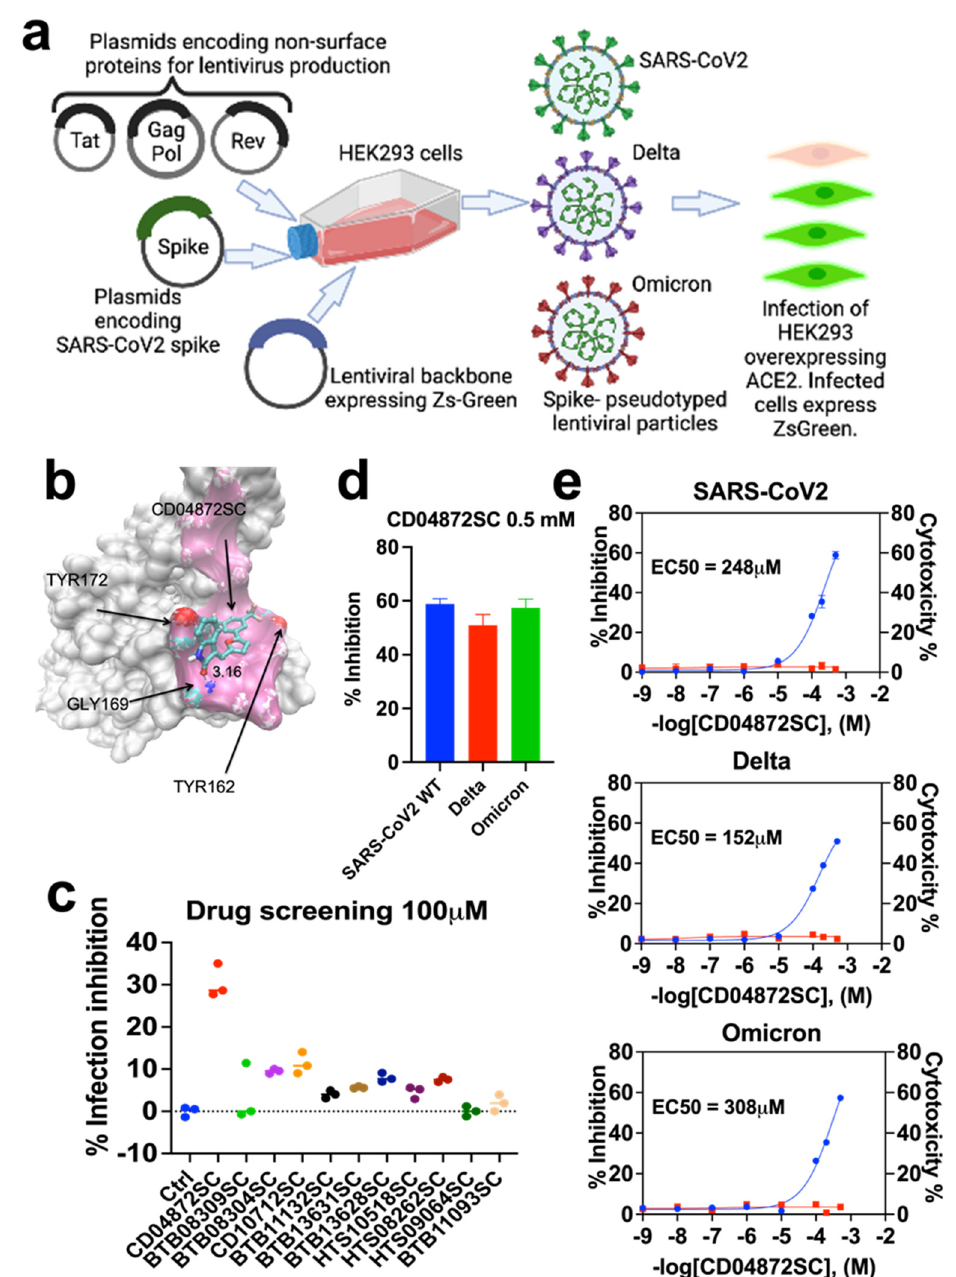
Figure 1. Lentiviral system approach and antiviral activities of the test drugs against SARS-CoV-2 and its variants Delta and Omicron in vitro. ( a ) HEK293 cells were transfected with a plasmid encoding a lentiviral backbone (genome) expressing a marker protein, a plasmid expressing spike proteins of SARS-CoV-2 and its variants Delta and Omicron, and plasmids expressing the other proteins needed for virion formation (Tat, Gag-Pol, and Rev). The transfected cells produced lentiviral particles with SARS-CoV-2 spikes on their surface. These viral particles can infect cells that overexpress the ACE2 receptor. The readout to measure the grade of viral infection is the green fluorescence of ZsGreen1 from infected cells. ( b ) The molecular structure shows the interface of the receptor-binding